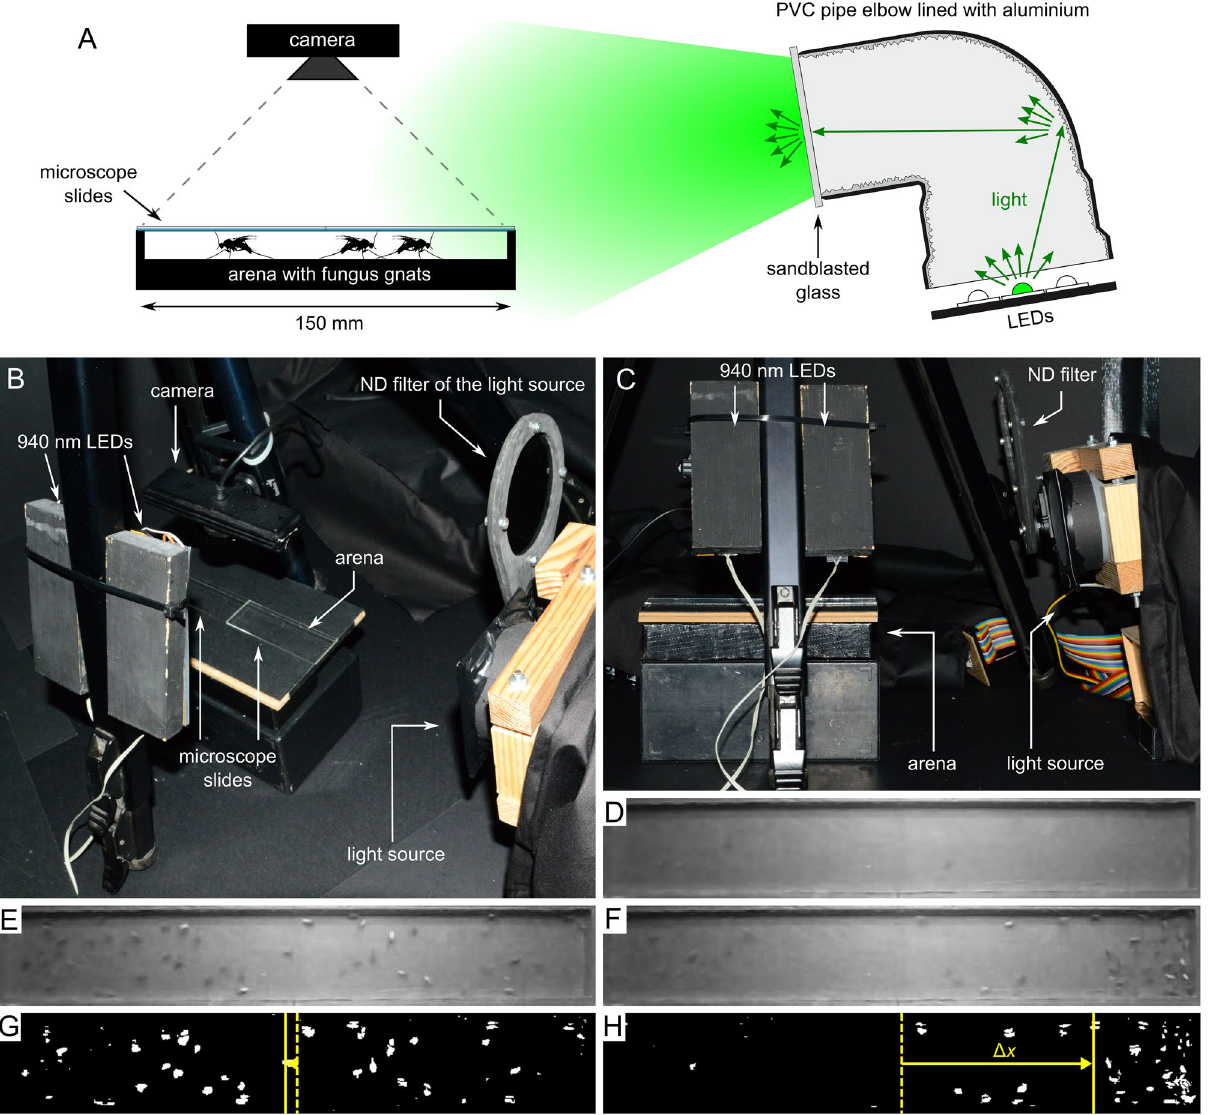
Figure 1. Experimental setup of behavioural experiment 1 and the evaluation process of the images. ( A ) Schematic diagram of the experimental setup. ( B , C ) Photograph of the setup. ( D ) Median image of the 10 photos corresponding to a stimulus (λ = 402 nm, photon flux = 3.61·10 8 photons/cm 2 /s). ( E ) First image of the arena taken by the camera (beginning of the same light stimulus). ( F ) Sixth image taken by the camera (end of the same light stimulus) with L. ingenua individuals congregating on the bright (right) side of the arena. ( G , H ) Thresholded image of ( E ) and ( F ) with yellow dashed and solid lines representing the arena midperpendicular and the horizontal component of the centroid of the white pixels, respectively. Centroid bias Δ x is shown by horizontal yellow arrows ( G : Δ x = − 0.295 cm; H : Δ x = 4.824